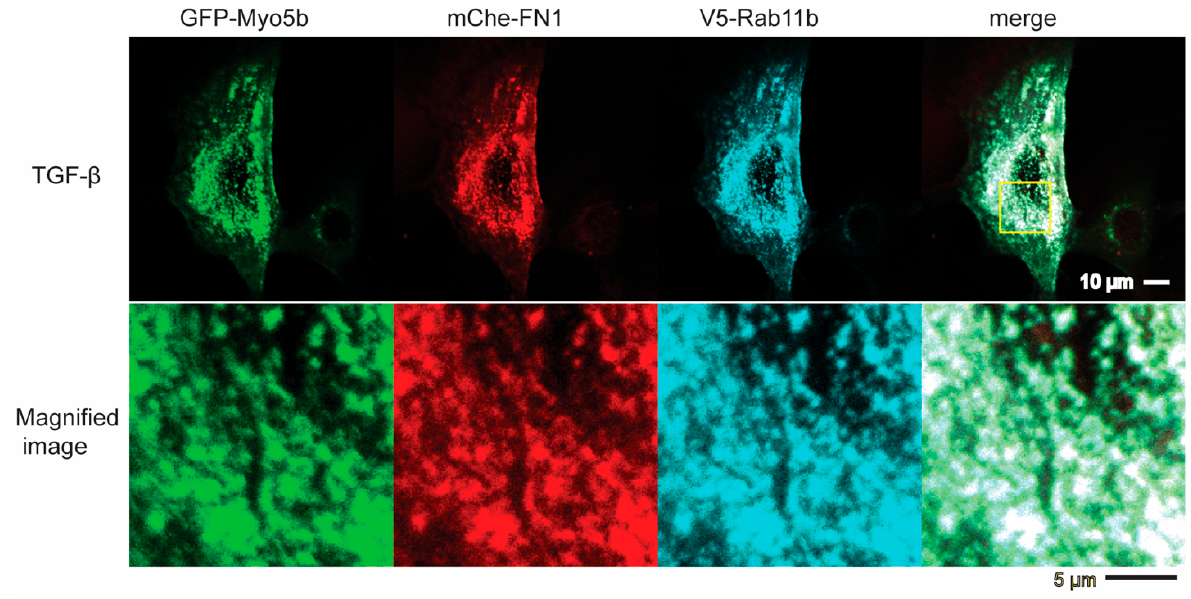
Figure 7. Colocalization of Myo5b, Rab11b and FN1. Confocal images of localization of GFP-Myo5b, mCherry-FN1 and V5-Rab11b in HPMCs after TGF- β stimulation. GFP- Myo5b (green), mCherry- FN1(red) and V5-Rab11b (cyan) were expressed in HPMCs and subjected to confocal microscopy. After fixation, the cells were stained with anti-GFP, anti-v5 antibodies, respectively. Bottom panels are enlarged images of the boxed area in the top. Scale bar, Upper: 10 µ m, Lower: 5 µ m. Representative image of n = 6 cells.